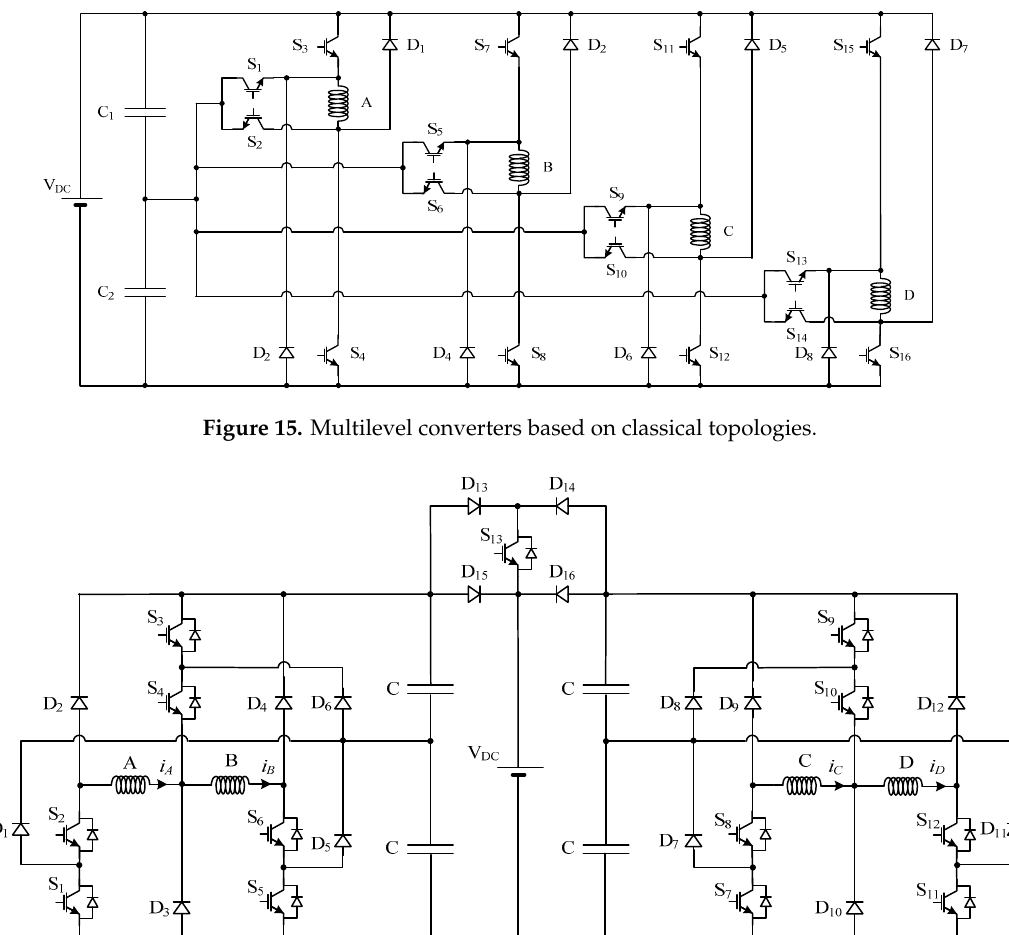
Figure 15. Multilevel converters based on classical topologies.